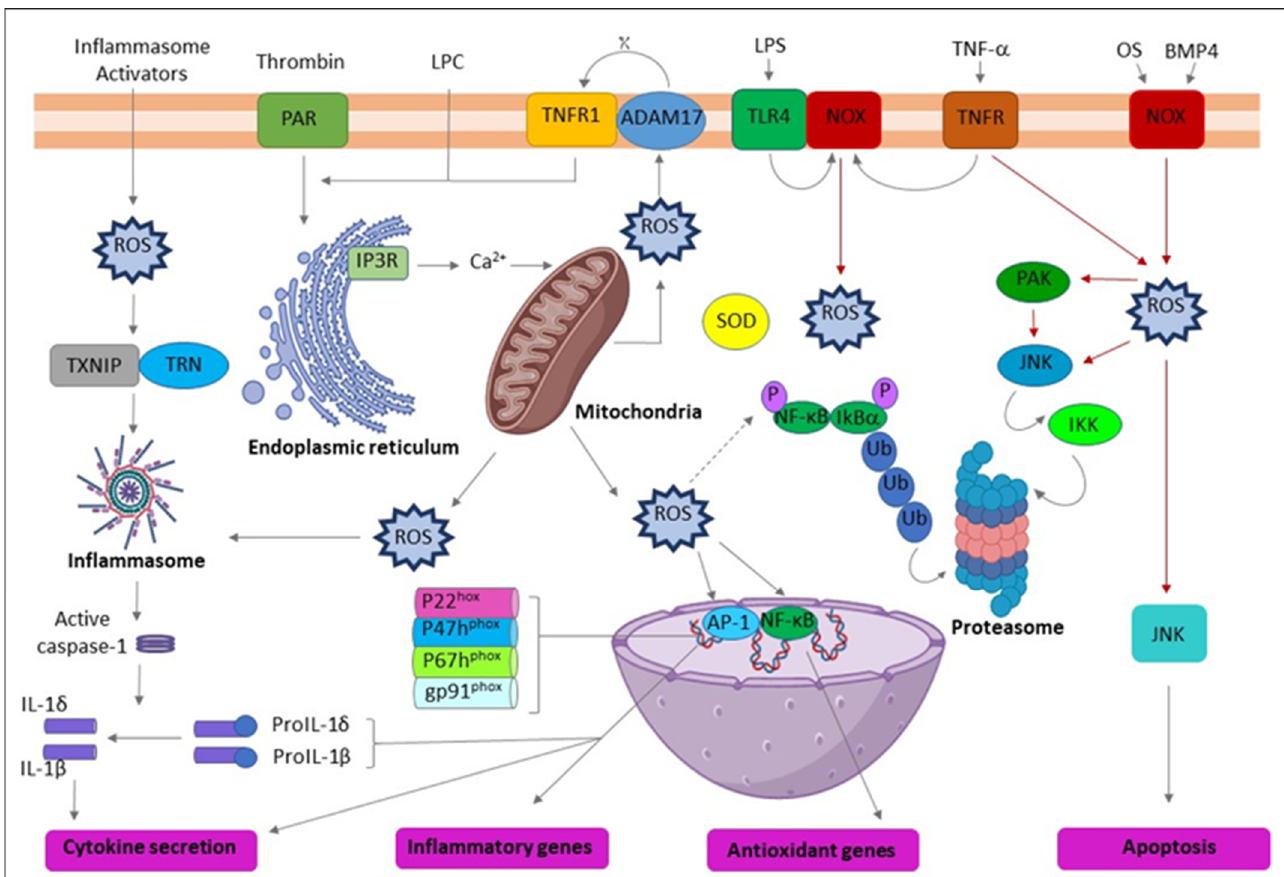
Figure 2. Schematic representation of the action of reactive oxygen species (ROS) leading to inflammation. ADAM17 (ADAM metallopeptidase domain 17); ASC (Activating signal co-integrator 1); BMP4 (Bone morphogenetic protein 4); IKB- α (Inhibitor of nuclear factor kappa B kinase regulatory subunit alpha); IKK (Inhibitor of nuclear factor kappa-B kinase); IP3R (Inositol 1,4,5-trisphosphate receptor type 3); JNK (c-Jun N-terminal kinase); LPC (Lysophosphatidylcholine); LPS (Lipopolysaccharide); NF- к B (Nuclear factor kappa subunit B); NLRP3 (NLR family pyrin domain containing 3); NOX (NADPH oxidase); OxPL (Oxidized phospholipids); PAR (Par family cell polarity regulator); PAK (p21 (RAC1) activated kinase); SOD (Superoxide dismutase); TLR4 (Toll-like receptor 4); TNF- α (Tumor necrosis factor alpha); TNFR (TNF receptor superfamily); TNFR1 (TNF receptor superfamily 1); TXNIP (Thioredoxin interacting protein); Ub (Ubiquitin).